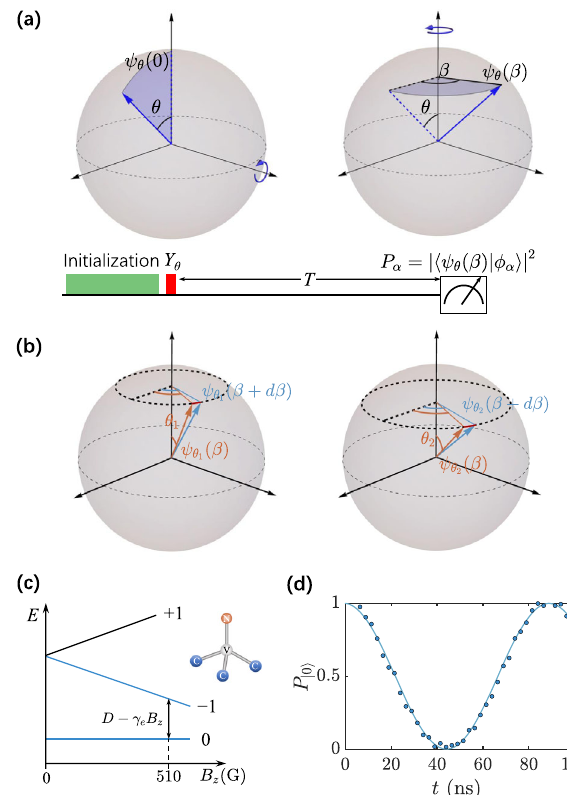
Fig. 1 Experimental setting. a Ramsey interferometry experiment for the estimation of an unknown phase parameter β . The quantum system is prepared in an initial resource state ψ θ ð 0 Þj i , the evolution of which results in a phase parameter β . The projective measure- ment on the fi nal state ψ θ ð β Þj i allows to determine the value of the parameter β . b The QFI of the fi nal state ψ θ ð β Þj i reveals the information content relative to the unknown phase parameter β . The larger QFI (right) implies the better distinguishability between the states ψ θ ð β Þj i and ψ θ ð β þ d β Þj i that have an in fi nitesimal parametric difference d β → 0. c The energy level structure of the NV center spin in diamond under an external magnetic fi eld. The two-level quantum system is encoded by the ground state spin sublevels m s = 0, − 1. d Rabi oscillations: the population in the spin state m s = 0 as a function of time, which facilitates ef fi cient coherent control of the NV center spin